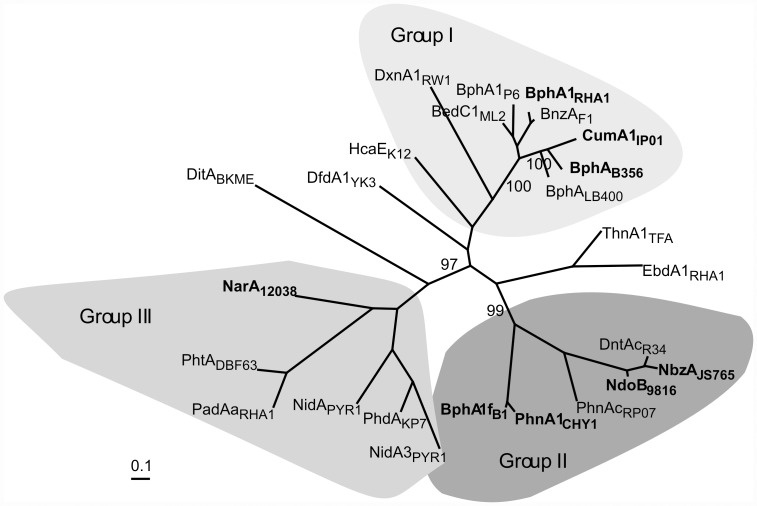
Unrooted phylogenetic tree obtained from a crystal structure-based sequence alignment of 25 α-subunits of related Rieske Oxygenases.Bootstrap values out of 100 replicates are indicated. The proteins are abbreviated using the gene name and strain as follows: biphenyl dioxygenase from Pandoraea pnomenusa B-356 (BphAB356, GenPeptID: AAC44526), Burkholderia xenovorans LB400 (BphALB400, GenPeptID: YP_556409), Rhodococcus globerulus P6 (BphA1P6, GenPeptID: CAA56346), Rhodococcus jostii RHA1 (BphA1RHA1, GenPeptID: BAA06868), and Sphingobium yanoikuyae B1 (BphA1fB1, GenPeptID: ABM91740); benzene dioxygenase from Pseudomonas putida ML2 (BedC1ML2, GenPeptID: Q07944); benzoate dioxygenase from P. putida F1 (BnzAF1, GenPeptID: A5W4F2); cumene dioxygenase from Pseudomonas fluorescens IP01 (CumA1IP01, GenPeptID: BAA07074); dibenzofuran dioxygenase from Terrabacter sp. YK3 (DfdA1YK3, GenPeptID: BAC06602); diterpenoid dioxygenase from Pseudomonas abietaniphila BKME (DitABKME, GenPeptID: AAD21063); dinitrotoluene dioxygenase from Burkholderia cepacia R34 (DntAcR34, GenPeptID: AAL50021); dibenzo-p-dioxin dioxygenase from Sphignomonas (DxnA1RW1, GenPeptID: CAA51365); ethylbenzene dioxygenase from R jostii RHA1 (EbdA1RHA1, GenPeptID: BAC92718); 3-phenylpropionate dioxygenase from E. coli K-12 (HcaEK12, GenPeptID: ACB03690); naphthalene dioxygenase from Rhodococcus sp. NCIMB 12038 (NarA12038, GenPeptID: AAD28100) and Pseudomonas putida 9816-4 (NdoB9816, GenPeptID: P0A110); nitrobenzene dioxygenase from Comomonas sp. JS765 (NbzA JS765, GenPeptID: AAL76202); polyaromatic hydrocarbon dioxygenase from Mycobacterium vanbaalenii PYR-1(NidAPYR1, GenPeptID: AAF75991, NidA3PYR1, GenPeptID: AAY85176) and Burkholderia sp. RP007 (PhnAcRP07, GenPeptID: AAD09872); phthalate dioxygenase from R. jostii RHA1 (PadAaRHA1, GenPeptID: ABG99212) and Terrabacter sp. DBF63 (PhtADBF63, GenPeptID: BAC54156); phenanthrene dioxygenase from Nocardioides sp. KP7 (PhdAKP7, GenPeptID: BAA94708) and Sphingomonas sp. CHY1 (PhnA1CHY1, GenPeptID: CAG17576); and tetraline dioxygenase from Sphingomonas macrogoltabidus TFA (ThnA1TFA, GenPeptID: AAN26443). Proteins for which the crystal structure was used for alignment are indicated in bold text in the figure.